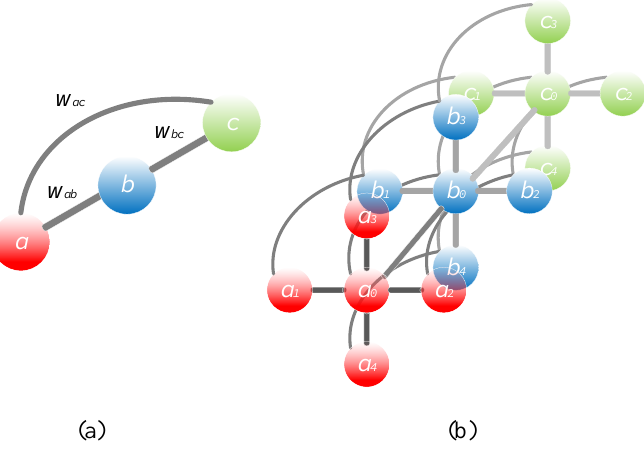
Figure 2. Example of connectivity on graph model. ( a ) Fully connected on three spectral bands. ( b ) Fully connected on four spatial